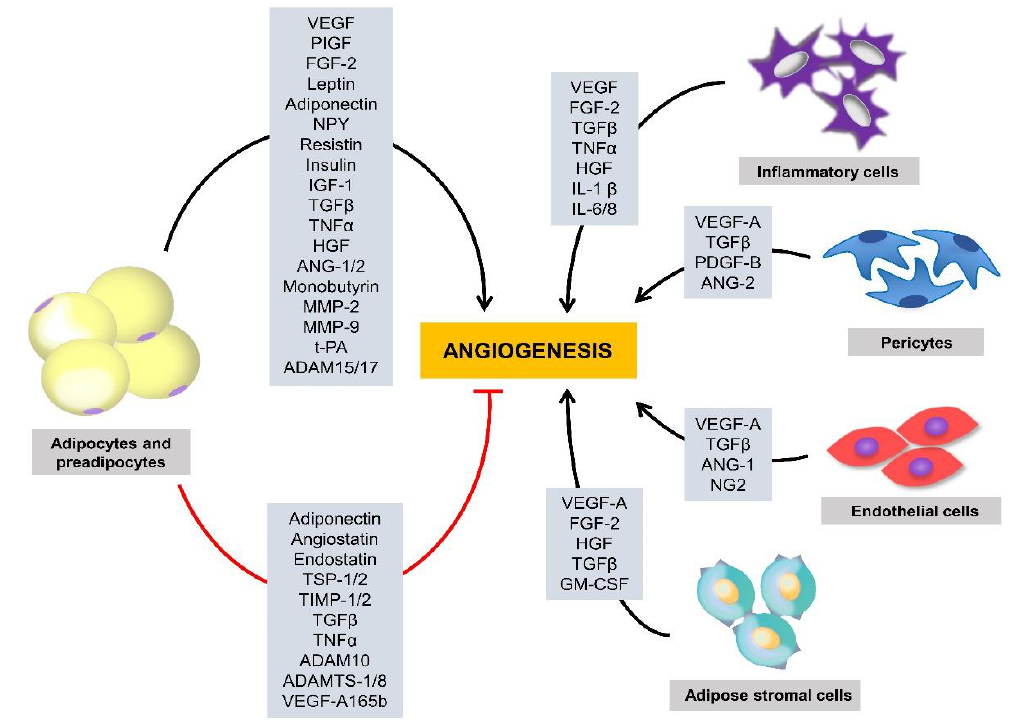
Figure 1. Regulation of adipose tissue angiogenesis by multiple factors. A variety of cells in adipose tissues, including preadipocytes, adipocytes, adipose stromal cells, pericytes, and endothelial cells, contribute to the production of multiple angiogenic stimulators and inhibitors that regulate adipose tissue angiogenesis. ADAM, a disintegrin and metalloproteinase; ADAMTS, ADAM with thrombospondin (TSP) motif; ANG, angiopoietin; FGF, fibroblast growth factor; GM-CSF, granulocyte macrophage colony-stimulating factor; HGF, hepatocyte growth factor; IL, interleukin; IGF-1, insulin-like growth factor 1; MMP, matrix metalloproteinase; NG2, neuron glial antigen 2; NPY, neuropeptide Y; PDGF, platelet-derived growth factor B; PlGF, placental growth factor; TGF β , transforming growth factor β ; TIMP, tissue inhibitor of MMP; TSP, thrombospondin; TNF α , tumor necrosis factor α ; t-PA, tissue-type plasminogen activator; VEGF, vascular endothelial growth factor.